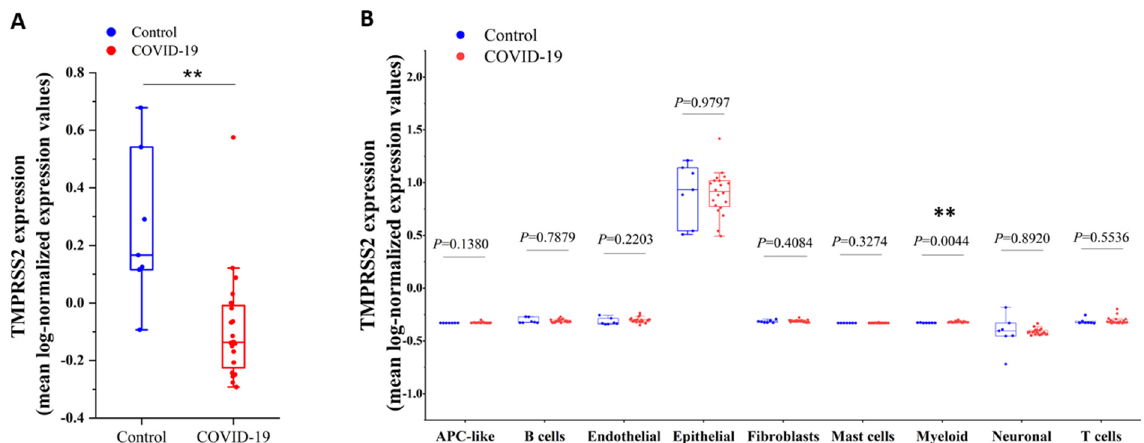
Figure 7. Expression of TMPRSS2 in SARS-CoV-2-infected lungs and control lungs. ( A ) Expression of TMPRSS2 in SARS-CoV-2-infected lungs and control lungs. ( B ) Expression of TMPRSS2 in different cell types in SARS-CoV-2-infected lungs and control lungs. “**”, p value < 0.01.